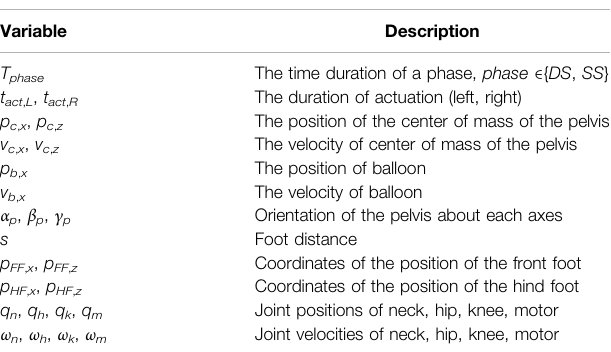
TABLE 2 | Potential state